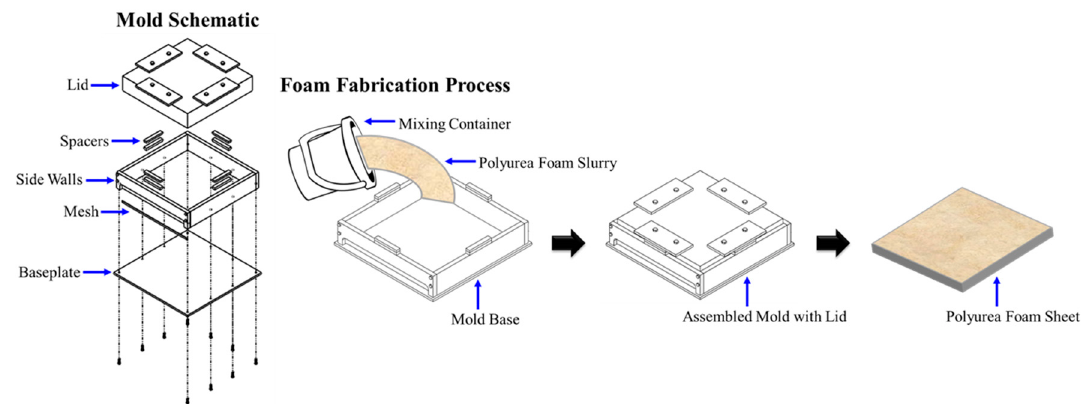
Figure 1. Schematic of the mold and foam fabrication process.